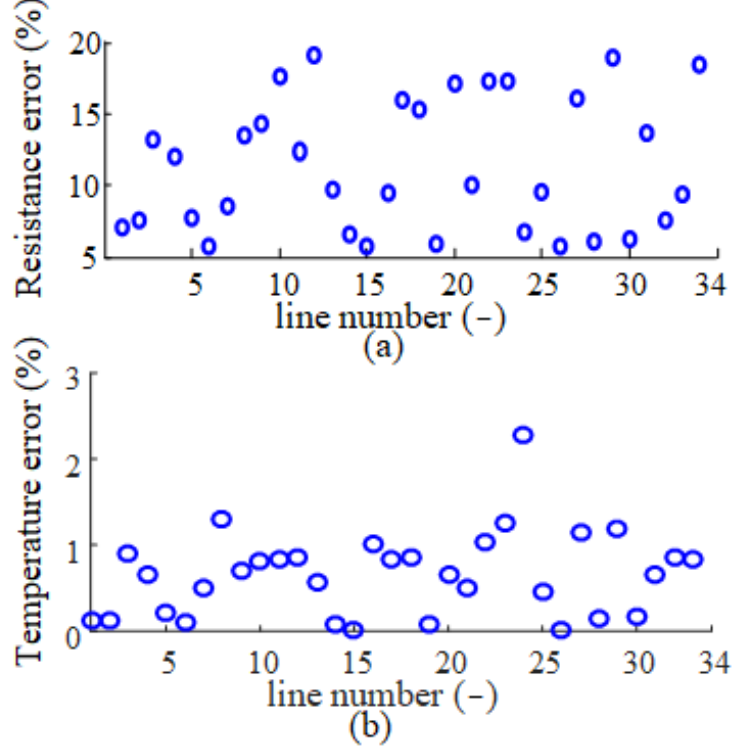
Figure 7. Resistance and line temperature error of the IEEE 39-bus system. ( a ) Resistance error, ( b ) temperature error.